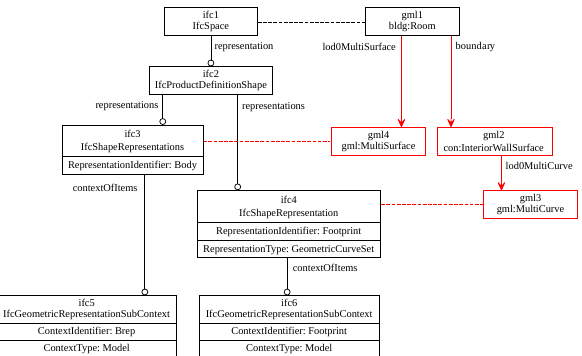
Figure 8. Population of CityGML rooms from IFC spaces.